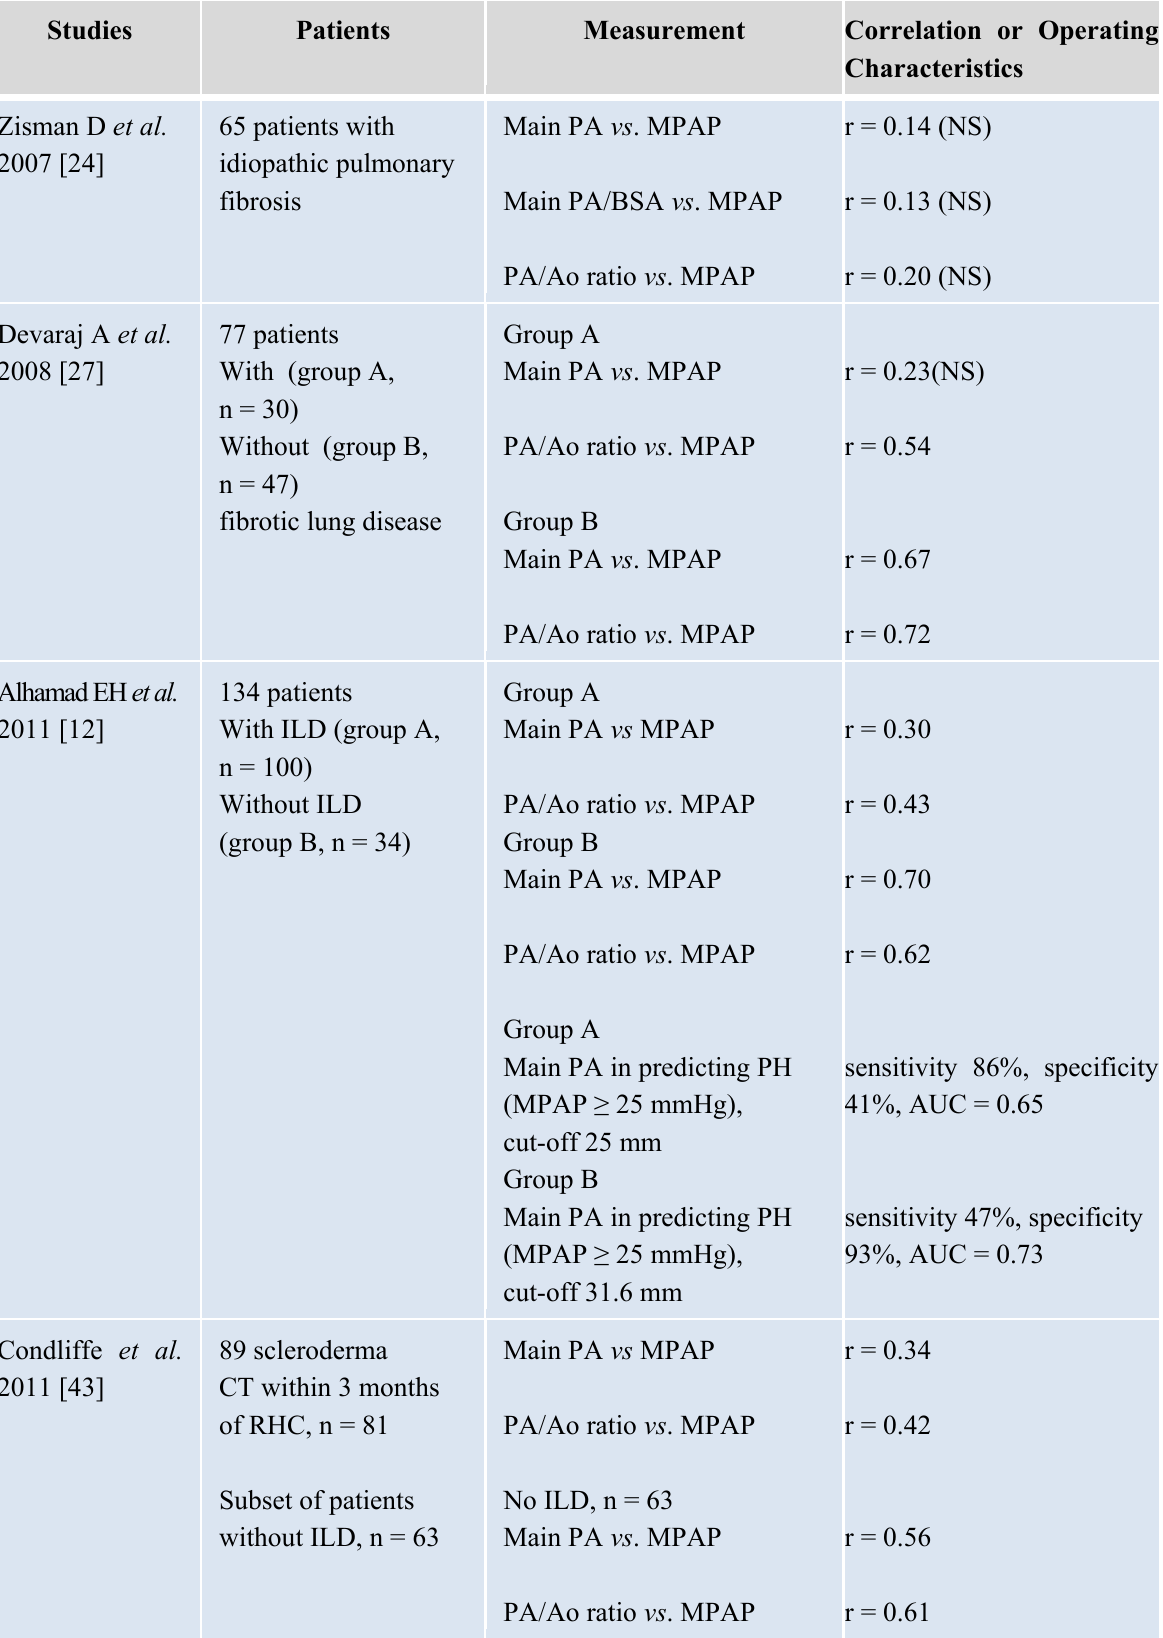
Table 2. CT measurement studies in patients with parenchymal lung disease (Subset of WHO Group 3 with fibrotic lung